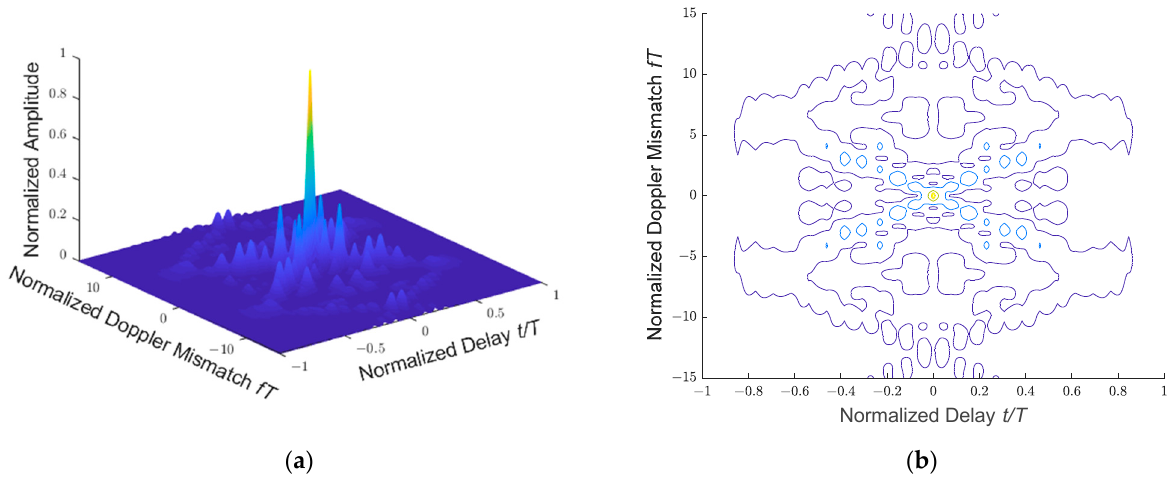
Figure 2. Ambiguity function of a 13-bit Barker code phase modulation signal: ( a ) ambiguity function of 3D perspective; ( b ) contour plot of ambiguity function in ( a ).